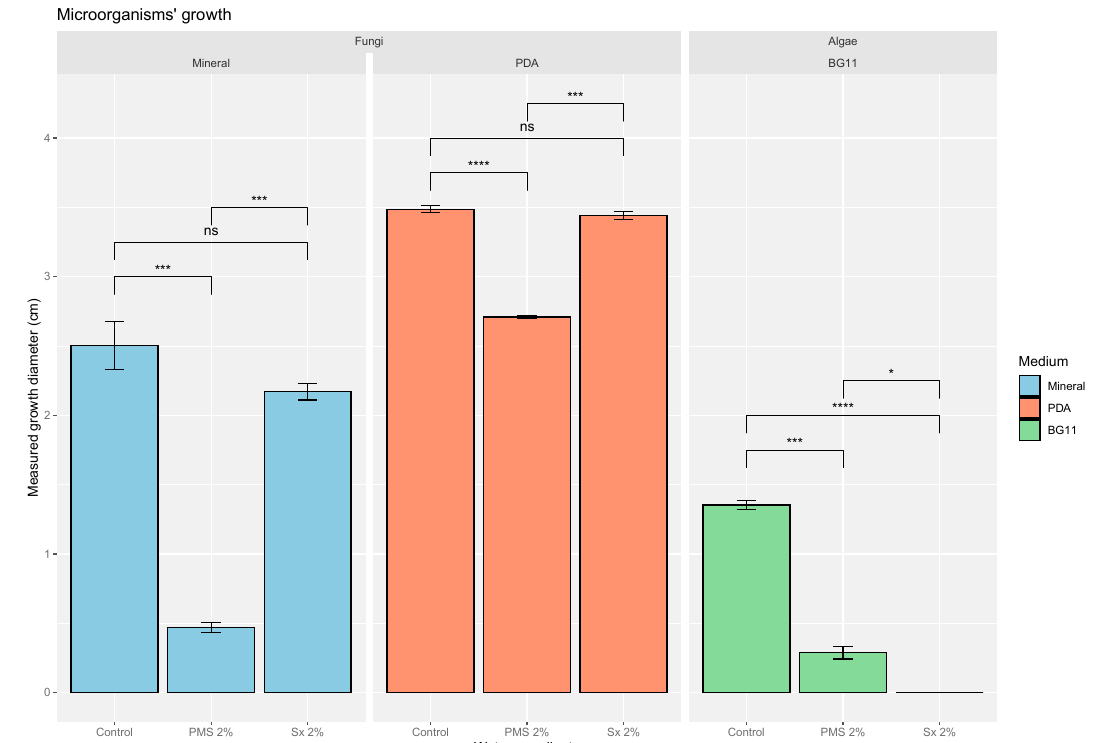
Figure 3. Fungal growth ( Cladosporium cladosporioides ) on mineral medium and PDA after 28 days with commercially used water-repellent concentrations (PMS 2%, and Sx 2%) and without water-repellent addition as the negative control. Algal ( Stichococcus bacillaris) growth on BG11 after 28 days with commercially used concentrations of water repellents (PMS 2%, and Sx 2%) and without water-repellent addition as the negative control. ns: non-significative, * 0.05 ≥ p value > 0.01, ** 0.01 ≥ p value > 0.001, *** 0.001 ≥ p value > 0.0001, **** 0.0001 ≥ p value.